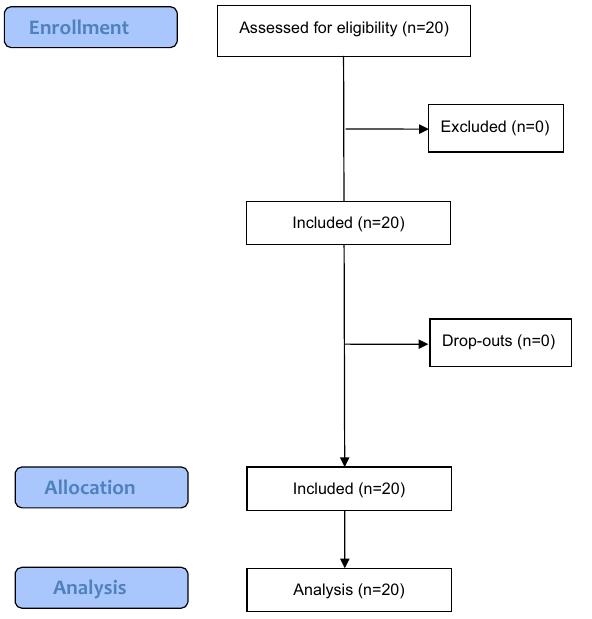
Figure 3. CONSORT 2010 Flow Diagram 37 of